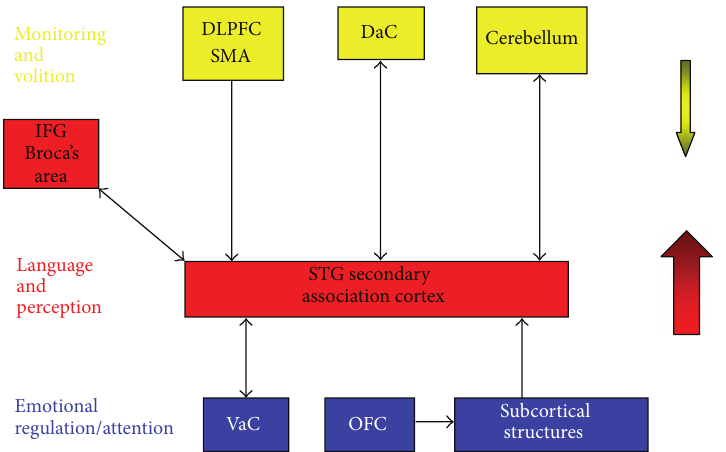
Figure 1: A neuroanatomical model of the hallucinating brain